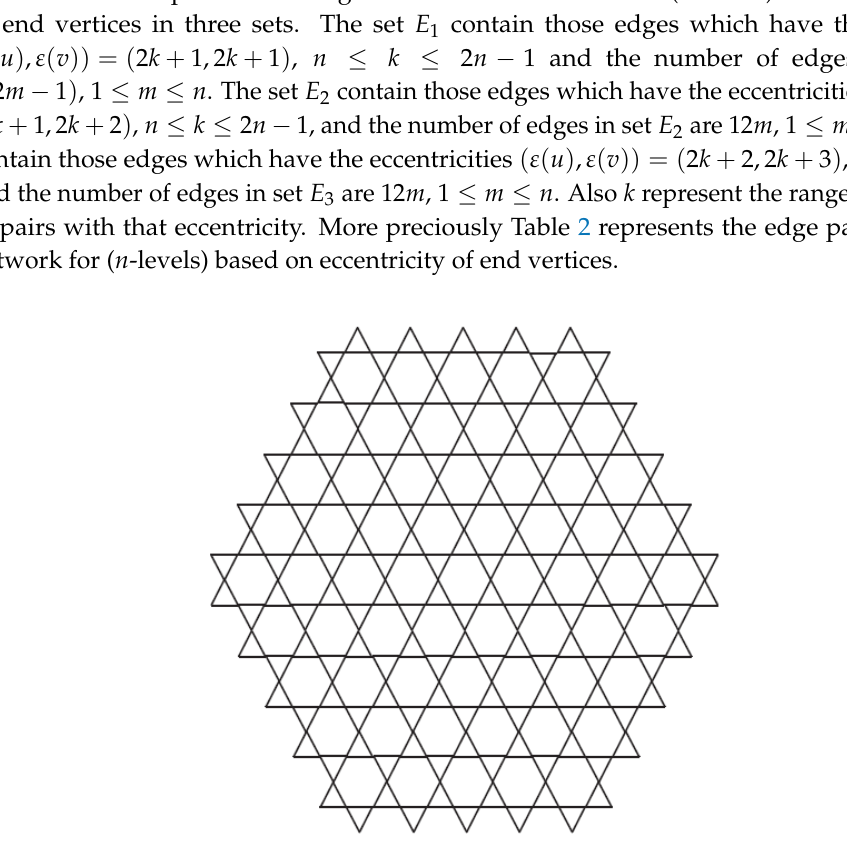
Figure 1. An oxide network OX n with n = 5. Table 1. Vertex partition of oxide network for ( n -levels) based on eccentricity of each vertex. ε ( u ) Number of Vertices Range of k Range of m and n Sets